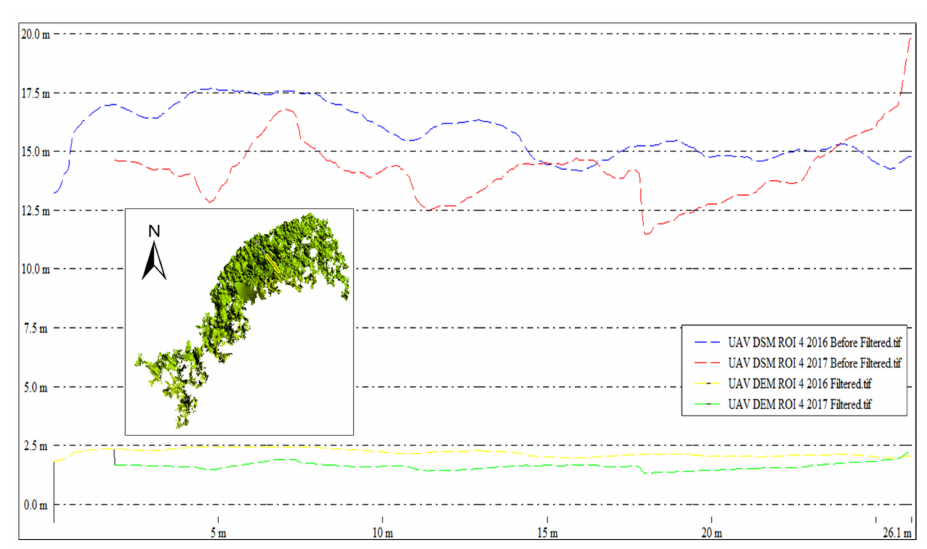
Figure A10. Average height comparison between filtered and unfiltered for ROI 4.